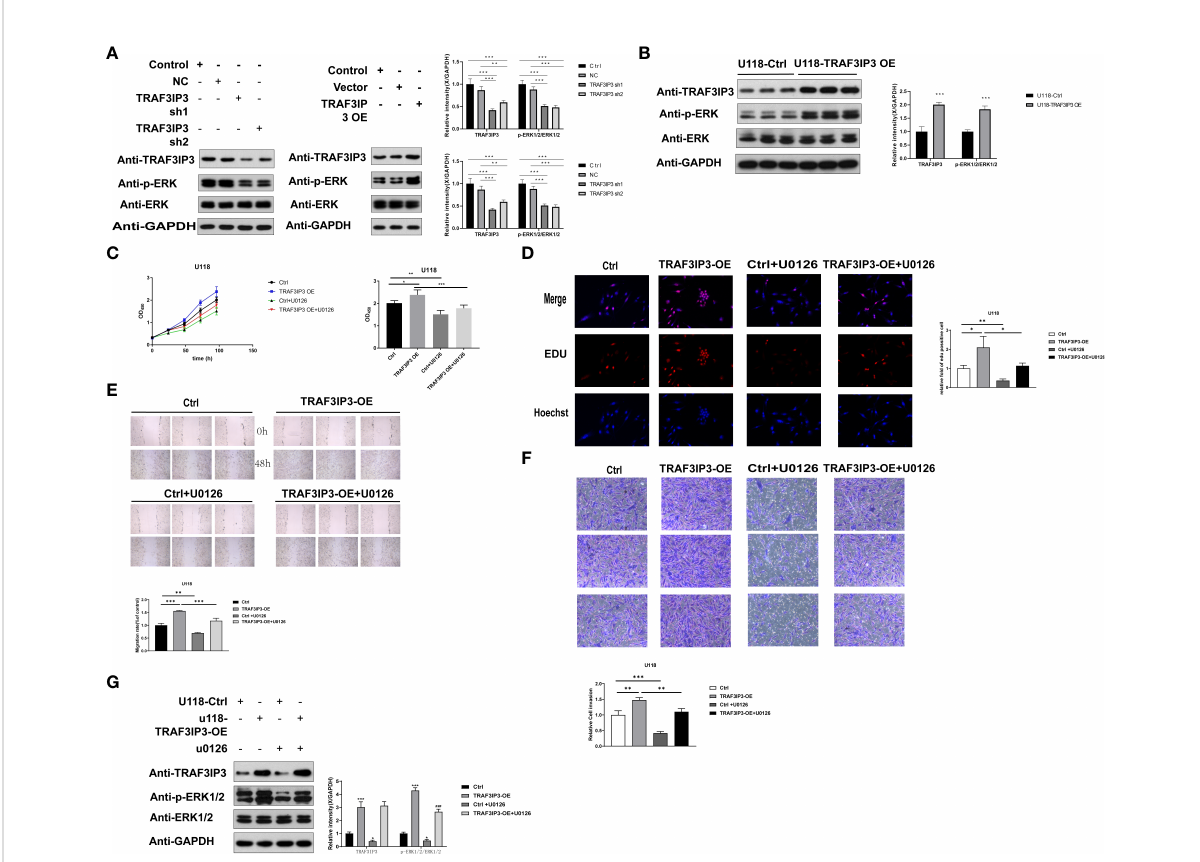
FIGURE 7 TRAF3IP3 promotes tumor progression via ERK signaling. (A) TRAF3IP3 knockdown in U251 cells decreased the phosphorylation of ERK, whereas TRAF3IP3 overexpression in U118 cells increased the phosphorylation of ERK. (B) TRAF3IP3 overexpression of U118 cells increased ERK activation. (C,D) CCK-8 assay and EdU assay showed that TRAF3IP3 activated the ERK signaling pathway to promote tumor proliferation, which could be rescued by U0126. (E) Wound-healing assay showed that TRAF3IP3 activated the ERK signaling pathway to promote tumor migration, which could be rescued by U0126. (F) Transwell assays showed that TRAF3IP3 activated the ERK signaling pathway to promote tumor invasion, which could be rescued by U0126. (G) The effect of TRAF3IP3 overexpression in activating ERK signaling pathway could be rescued by U0126. *p < 0.05, **p<0.01, ***p<0.001, ###